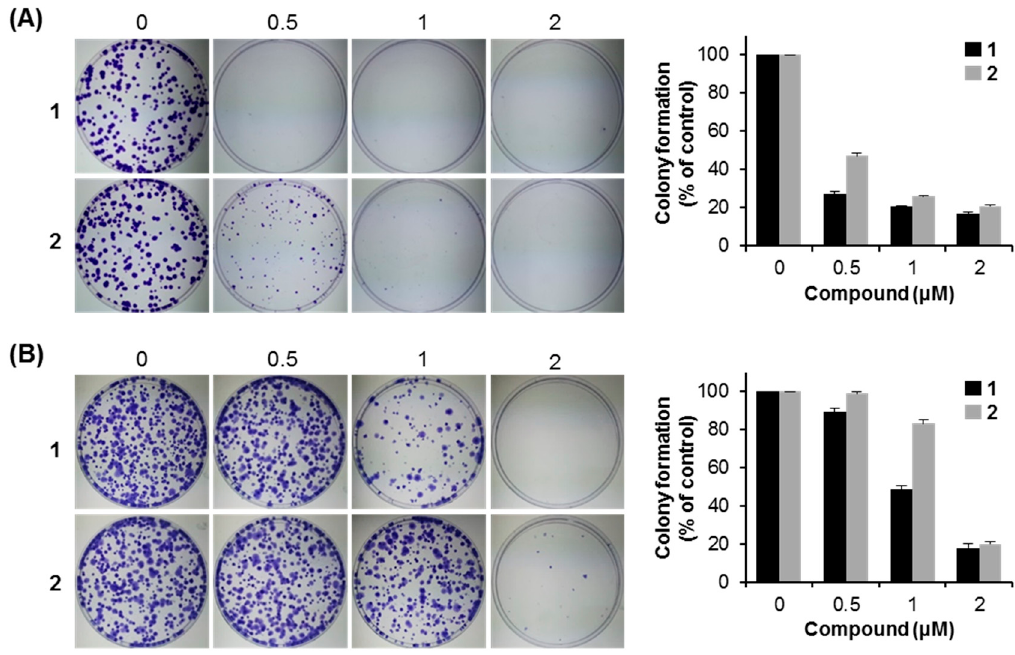
Figure 6. Cont. Figure 6.